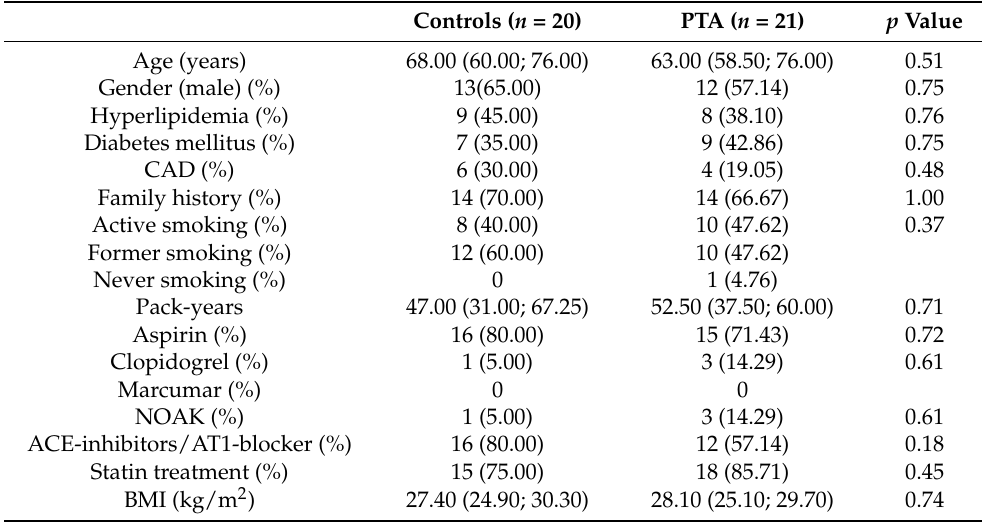
Table 1. Baseline categorical characteristics of the study